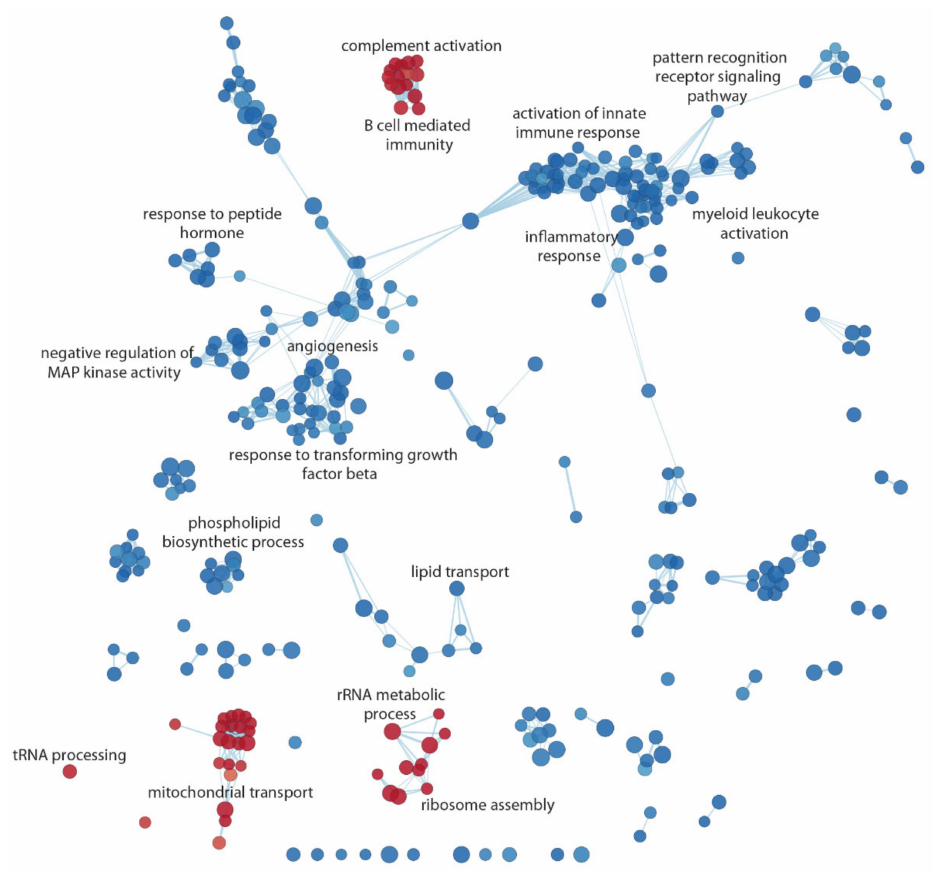
Figure 3. Enrichment map of the gene sets positively (red nods) and negatively (blue nodes) associ- ated with CAD, respectively. The network shows the most significant results of the GSEA with the Gene Ontology biological processes gene sets (FDR-adjusted p -value < 0.05).